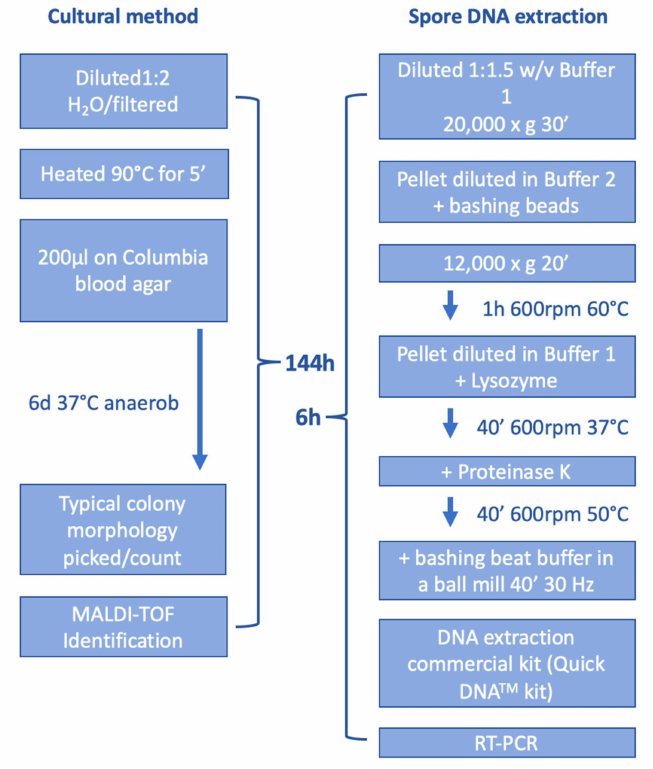
Figure 1. Detection of P. larvae . The cultural method takes 144 h whereas the direct DNA isolation from spores followed by RT-PCR takes 6